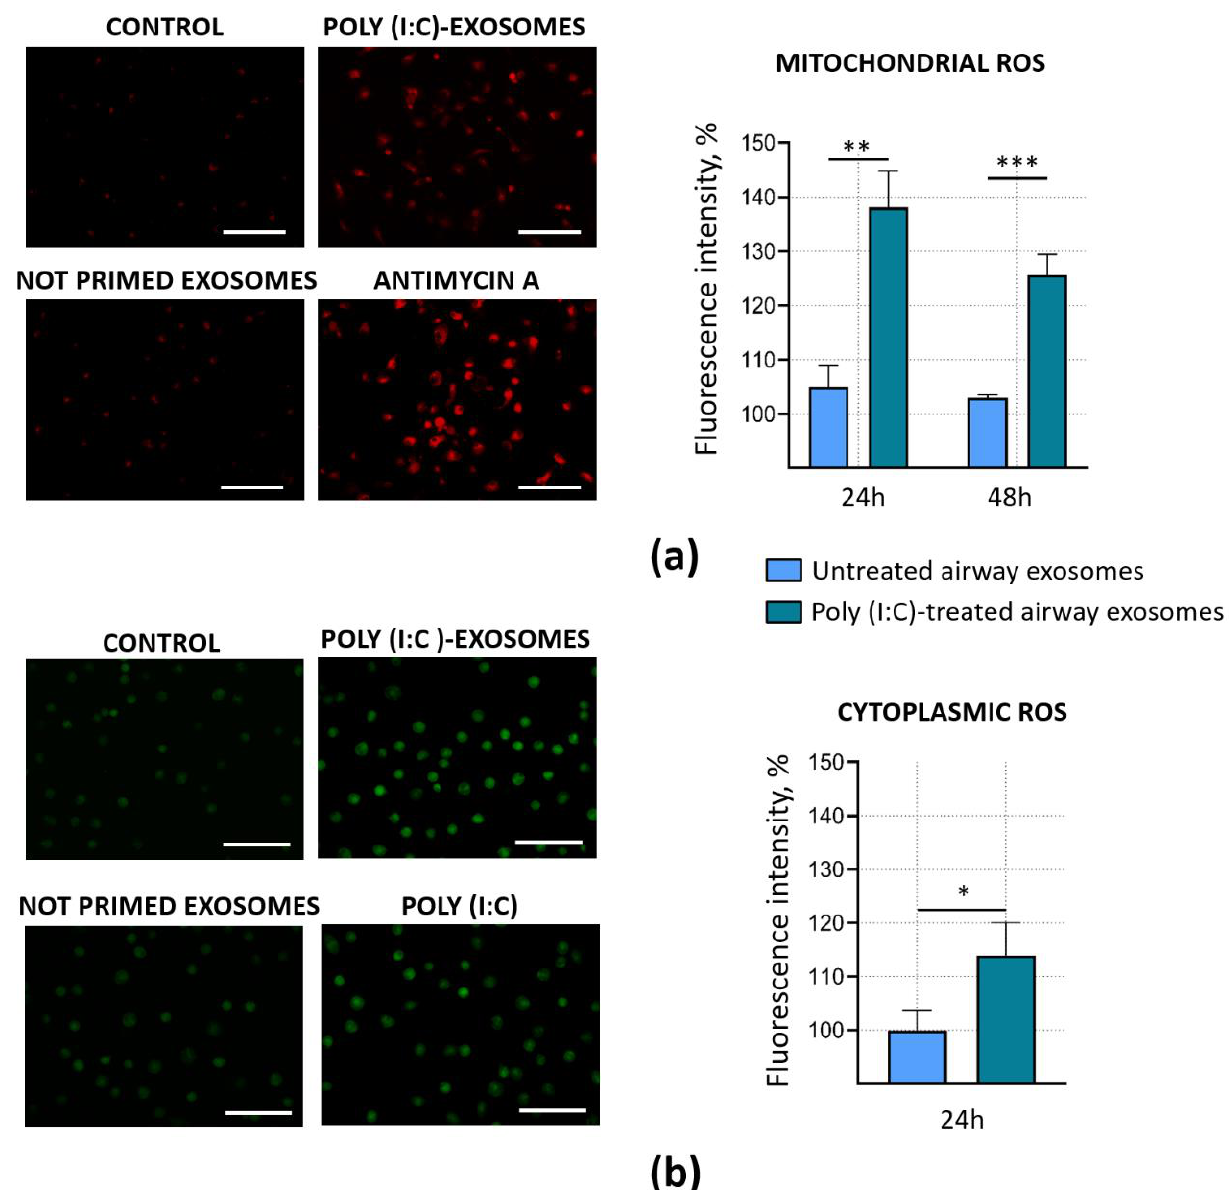
Figure 6. Intramitochondrial and cytoplasmic reactive oxygen species (ROS) formation in microglia after treatment with ELVs from poly (I:C)-primed airway cells. Cytoplasmic ROS were detected by DCFDA assay and mitochondrial superoxide— by MitoSOX TM fluorescence. ( a )—representative images and quantitative evaluation of MitoSOX fluorescence in cultured microglia. For positive control of the assay, 100 µ M Antimycin A was used. The scale bar is 100 µ m. ( b